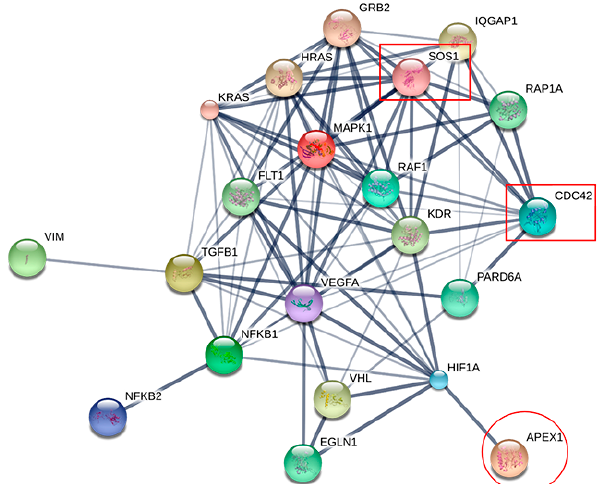
Figure 4 . The interaction map of APEX1 and metastatic process-associated proteins. APEX1 was associated with metastatic protein markers: cell division cycle 42 (CDC42) and son of sevenless homolog 1 (SOS1). Stronger associations are represented by thicker lines. Weak associations are represented by thin lines.